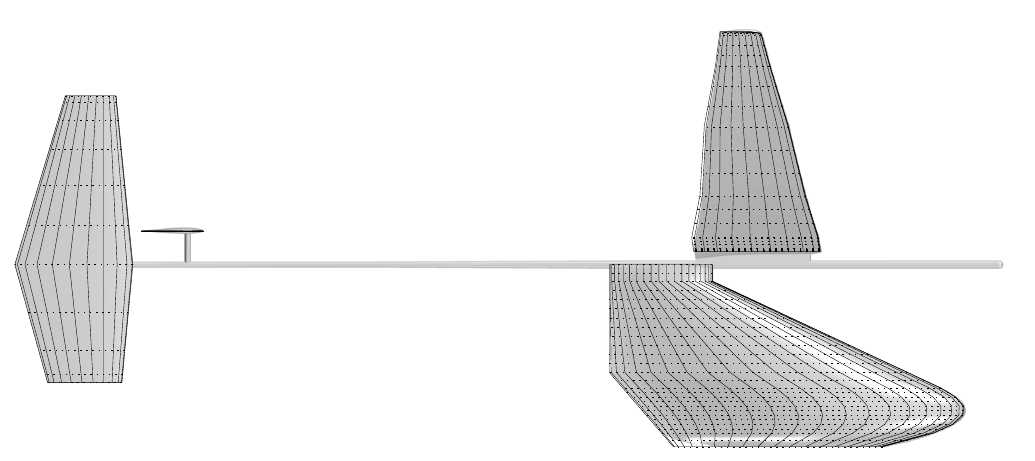
Figure 4. AVL model of the Daedalus plotted on top of its CAD